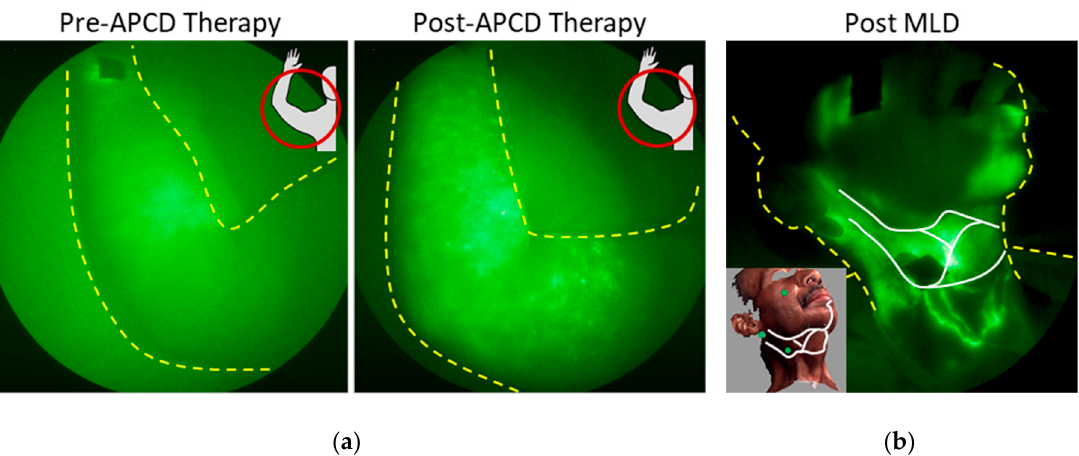
Figure 10. NIRF-LI images illustrating the movement of fluorescent lymph ( a ) through the extravascular space following APCD therapy in a breast-cancer-related lymphedema (BCRL) subject (adapted from [98], Adams, K.E., et al., 2010) and ( b ) across scar tissue following manual lymphatic drainage (MLD) in a head and neck cancer patient (adapted from [99], Maus, E.A., et al., 2012). The white lines in ( b ) represent the location of the scars from multiple surgeries in the neck and the green dots in the inset image show the location of the injection sites. Injection sites are covered with round bandages and/or black vinyl tape. The brightness and contrast of the images have been adjusted to facilitate the visualization of the 16-bit imaging depth.